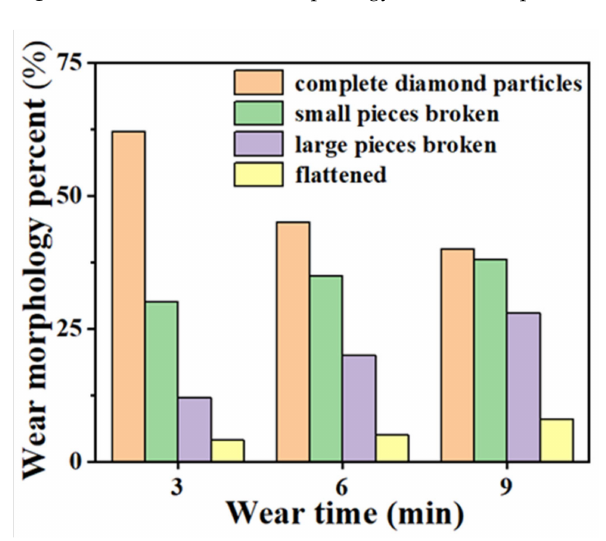
Figure 22. Different wear morphology of diamond particles.